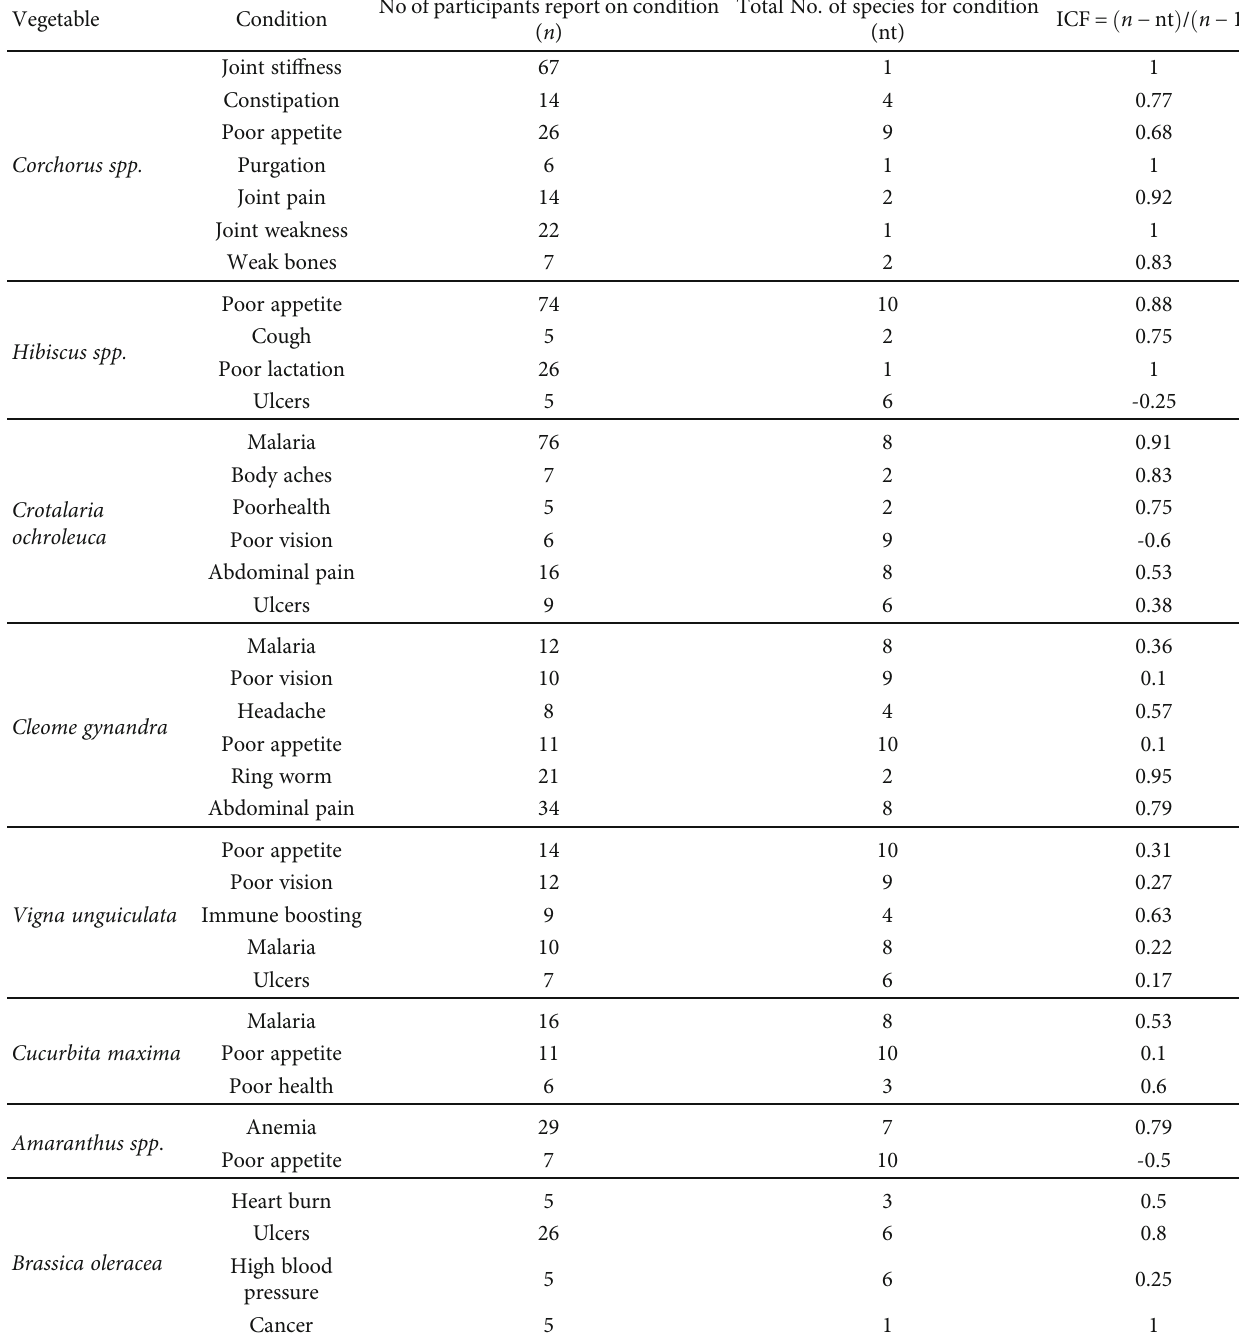
Table 3: ICF values for the diseases commonly treated by the traditional medicinal vegetables in Northern Uganda. Vegetable Condition